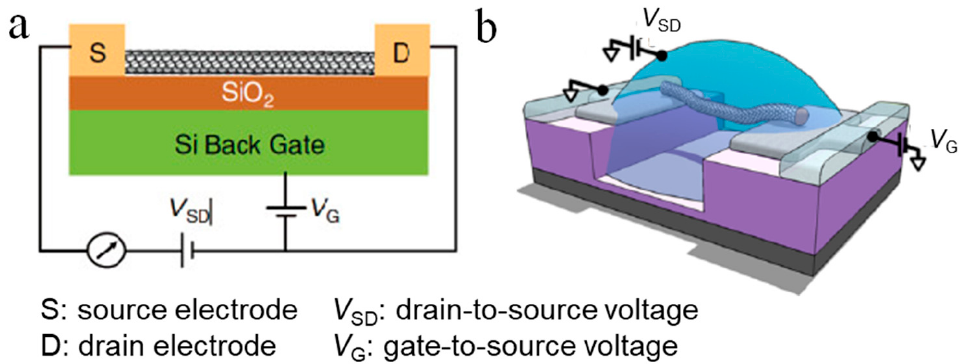
Figure 2. Illustration of CNT-based field-effect transistors (FETs) for sensing. ( a ) Schematic representation of a general CNTFET [17]. ( b ) Schematic diagram of an electrolyte-gated CNTFET [20].